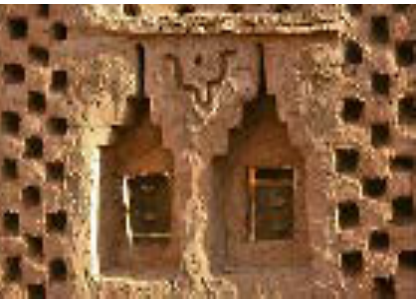
(Figure.2) some of the Amazing’s decorations in the farm houses that where common since ancient